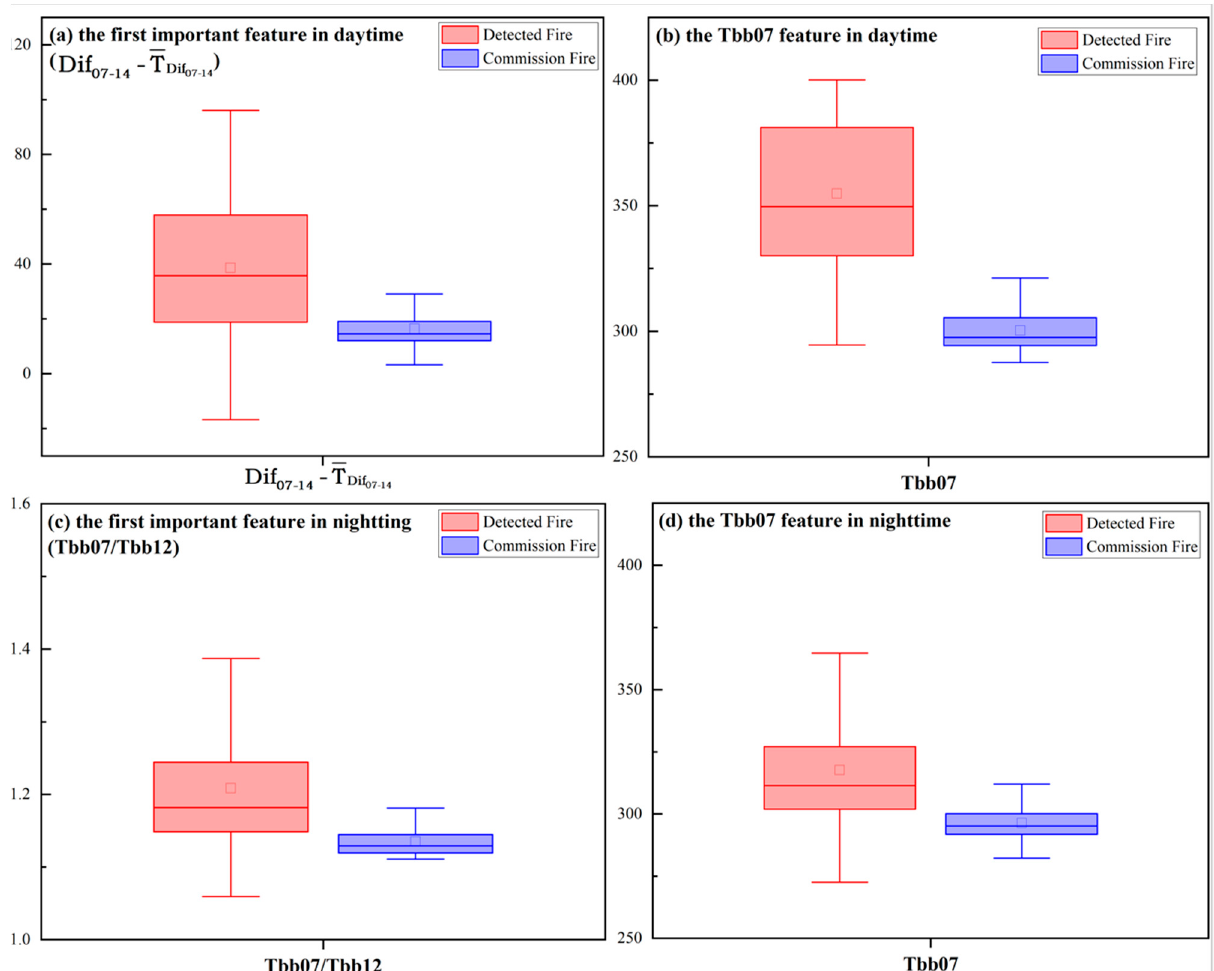
Figure 11. Distribution of detection and commission pixels for the first-ranked feature and Tbb07 feature in the RF-D and RF-N models. ( a , b ) show the distributions of the Dif 07–14 − T Dif and the Tbb07 feature at daytime fire pixels, respectively; ( c , d ) show the distributions of the Tbb07/Tbb12 feature and Tbb07 feature at nighttime fire pixels, respectively.